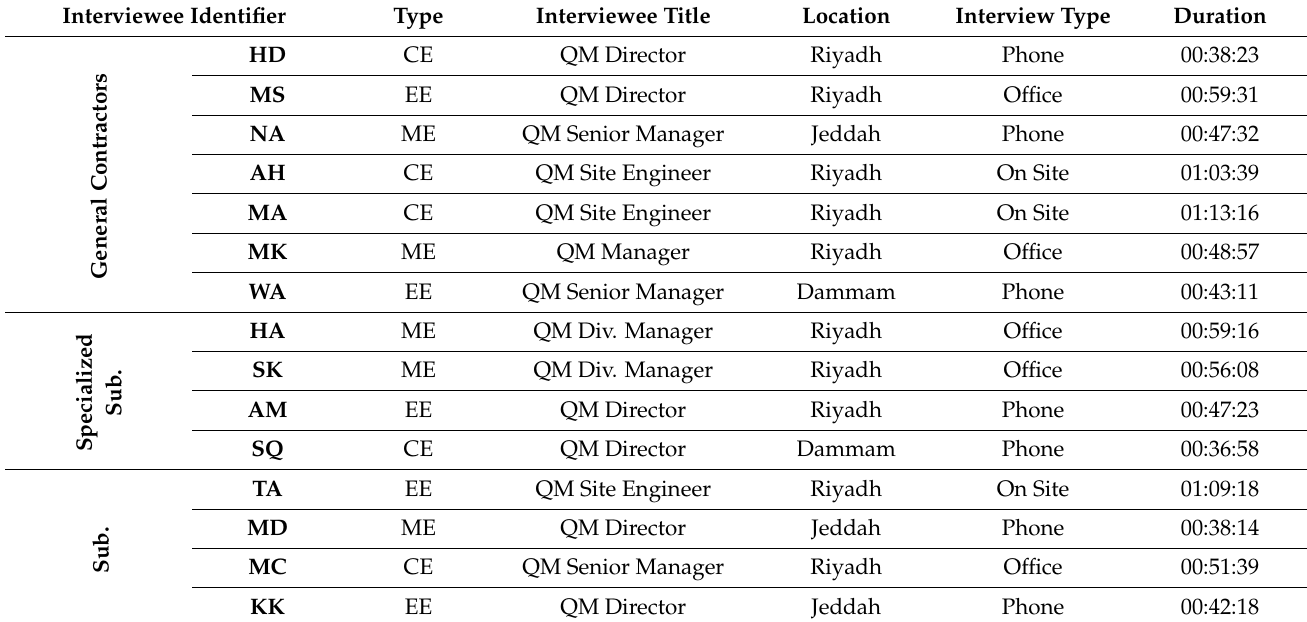
Table 4. Interview schedule (N = 15) (source: own